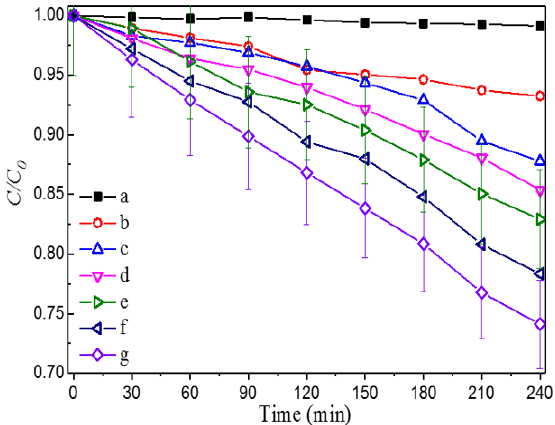
Figure 6. Degradation of sulfamethazine (SMT) on: ( a ) ZnO/Cu x O (5%) in the dark, ( b ) Cu x O, ( c ) ZnO/Cu x O (1%), ( d ) ZnO, ( e ) ZnO/Cu x O (2.5%), ( f ) ZnO/Cu x O (10%), and ( g ) ZnO/CuO (5%) under visible light (> 410 nm). Solution parameters: [catalyst] = 500 mg/L, [SMT] = 2.5 mg/L, initial pH 7.0, and visible light intensity 38.9 mW/cm 2.